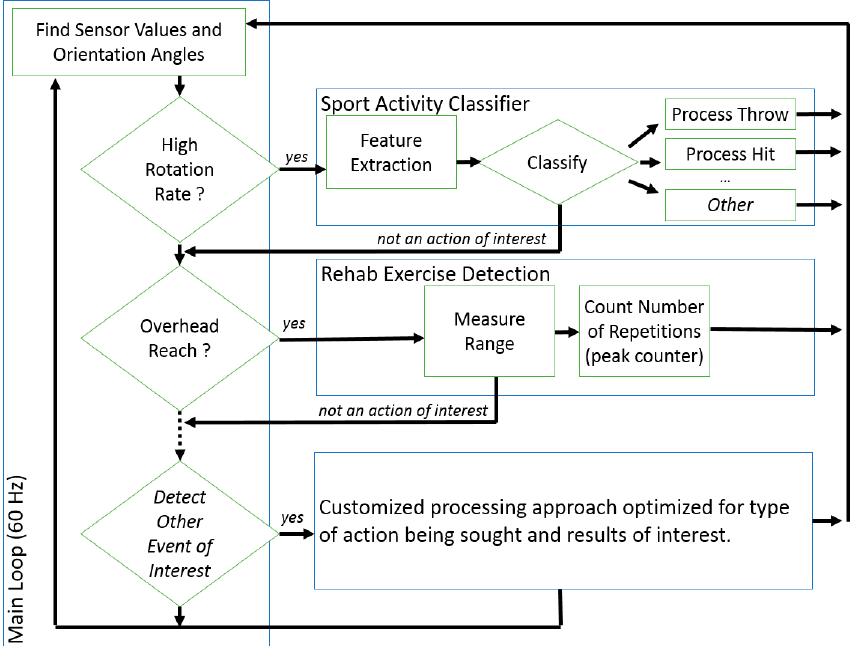
Figure 6. Illustration of a two-stage approach to gesture spotting and classification in real time.